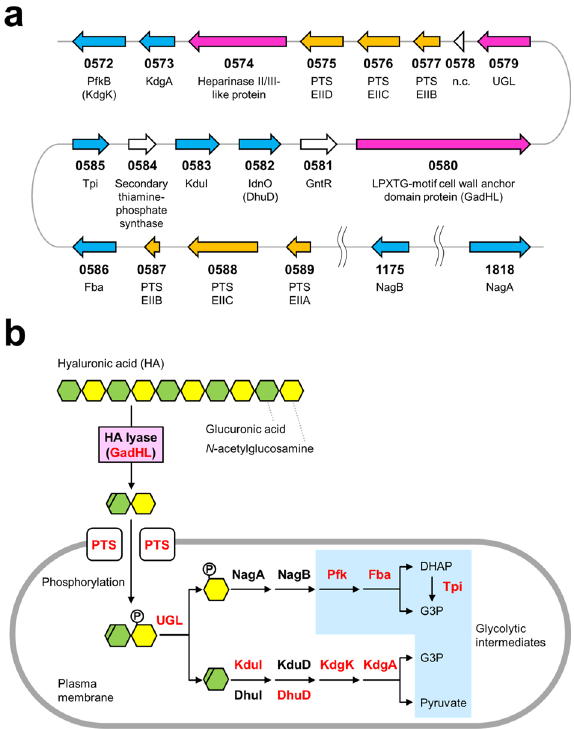
Figure 8. Action of GAG (HA) by G. adiacens . ( a ) GAG genetic cluster, including the gadHL and neighboring genes. Pink, genes for GAG degradation; orange, genes for substrate import by phosphotransferase system (PTS); blue, genes for GAG metabolism. ( b ) GAG assimilation model in G. adiacens . Red letters indicate proteins encoded by the genetic cluster found in this study. A novel type of GAG genetic cluster was found in some Granulicatella